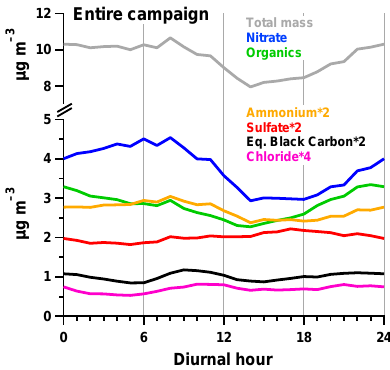
Figure 3. Diurnal variation (local time, LT) of individual species and the total mass, averaged over the whole ACSM